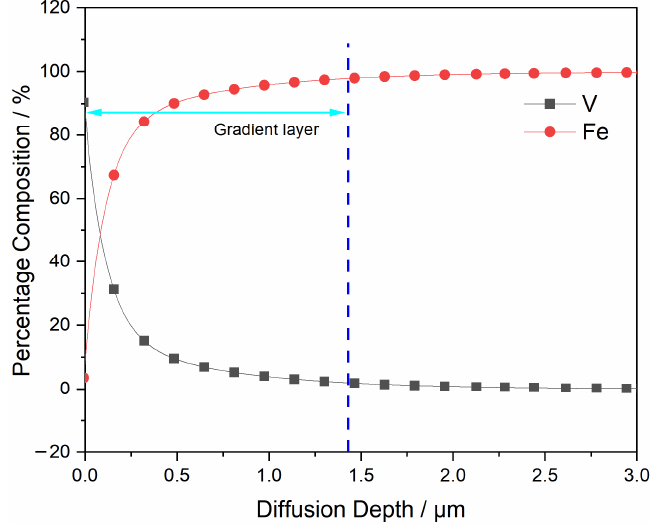
Figure 3. Distribution of Fe and V content of specimen sections at X NaF = 0.2. Light blue line is gradual range of vanadium deposition and dark blue line is the proportion of vanadium is reduced to 2.0 %.